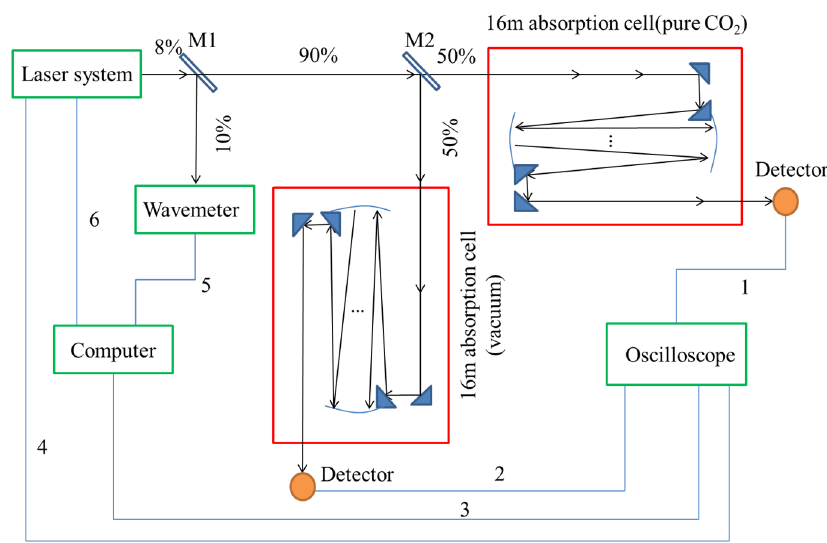
Figure 11. System configuration of the wavelength control unit.